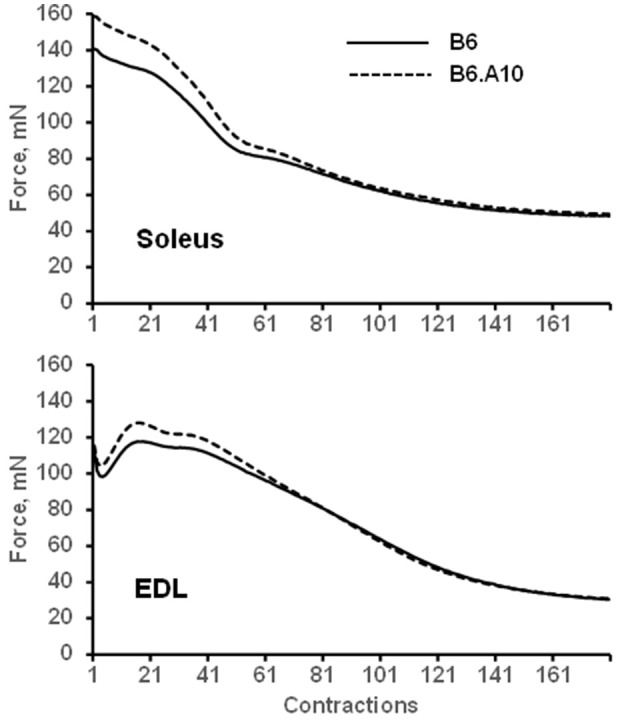
Fatigue of isolated muscle is not linked to chromosome 10 genotype. Mean force of 180 repeated contractions of slow-twitch soleus (top) and fast-twitch EDL (bottom) muscles are shown. Solid and dashed lines represent B6 and B6.A10 strains, respectively.